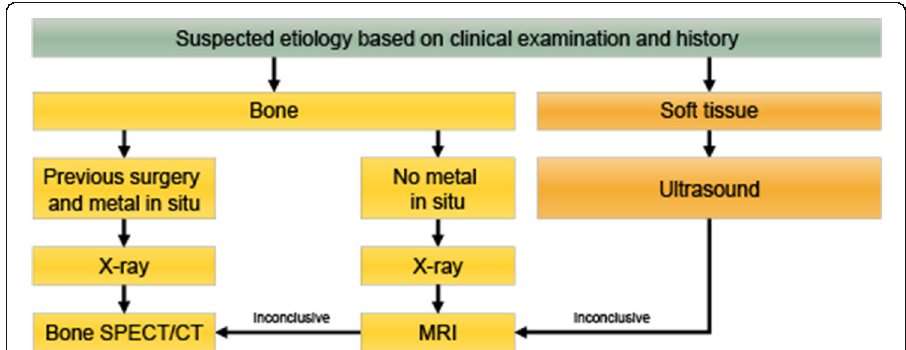
Fig. 5 Imaging algorithm painful foot and ankle. Imaging algorithm for assessing the painful foot and ankle. Modified from Mohan et al. (Mohan et al.